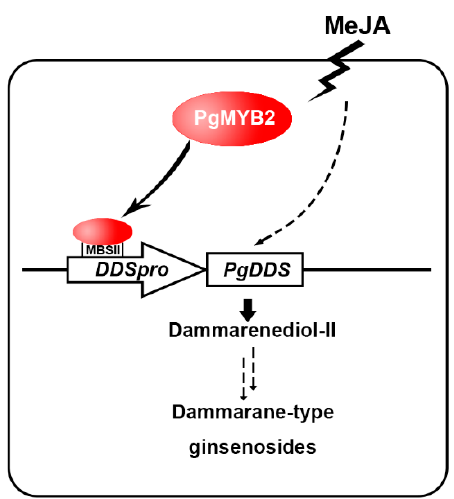
Figure 8. A proposed model describing the function of PgMYB2 in the ginsenoside pathway.